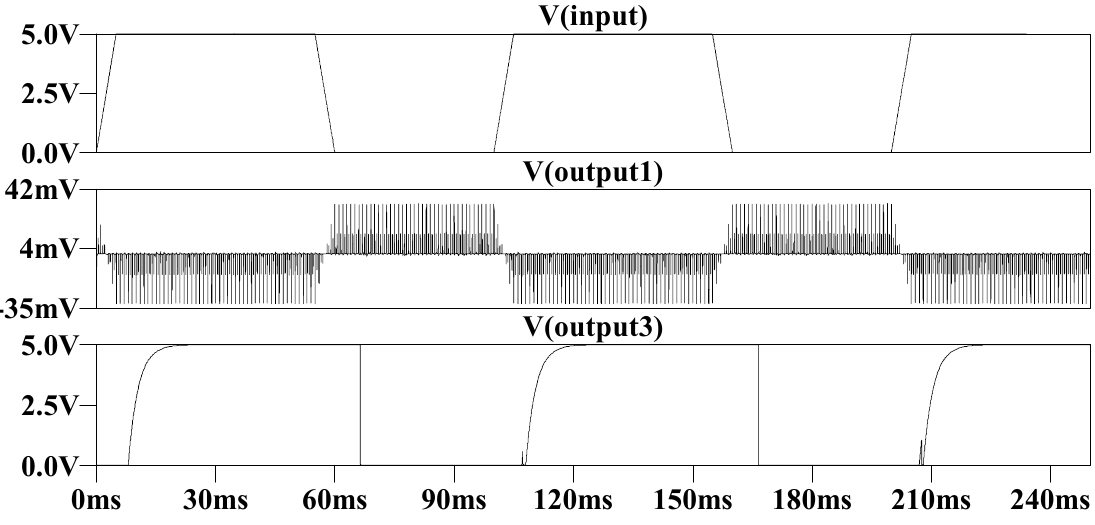
Figure 8. Waveform after considering parasitic capacitance effect.